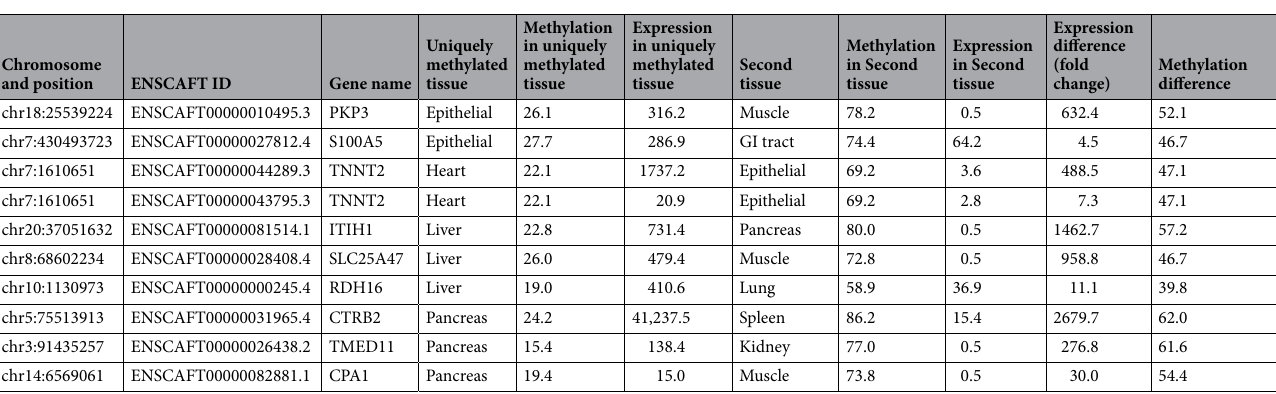
Table 2. Representative uniquely methylated CpG sites with